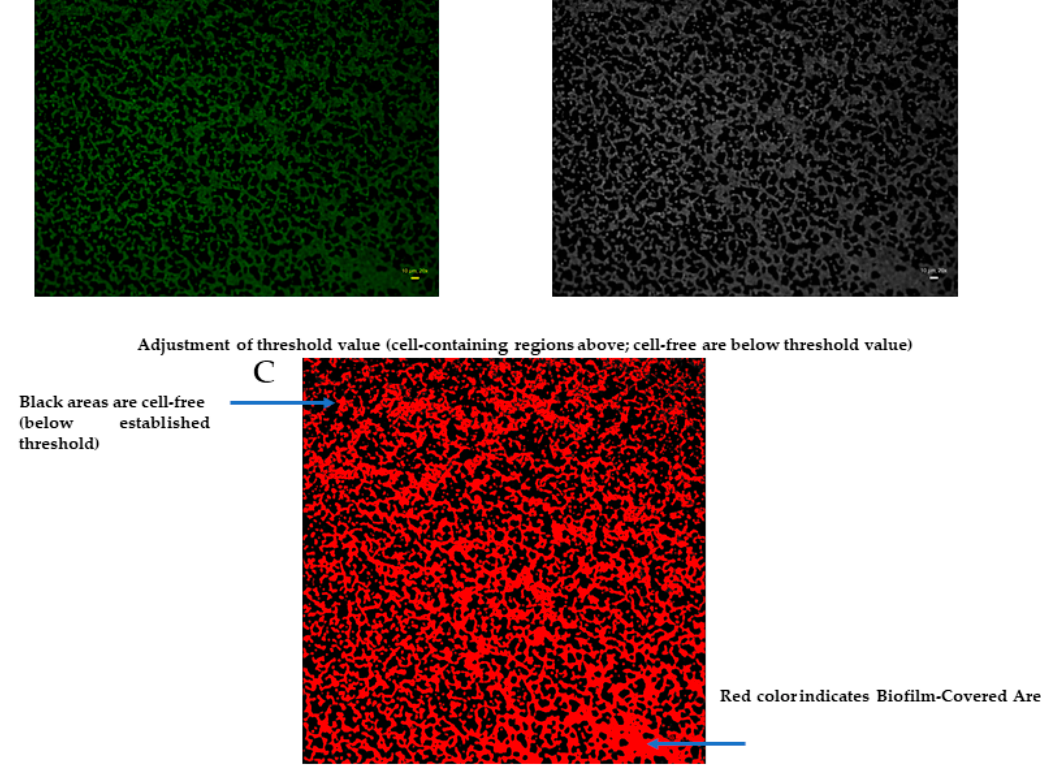
Figure 9 . Processing of biofilm image to extract the value of Biofilm-Covered Area [%]. ( A )–biofilm after treatment with antiseptic; ( B , C )—processing stages aiming to extract the value of BCA [%]. Data collected with wide-field Lumascope 620, 20×, scale bare is 10 µm.